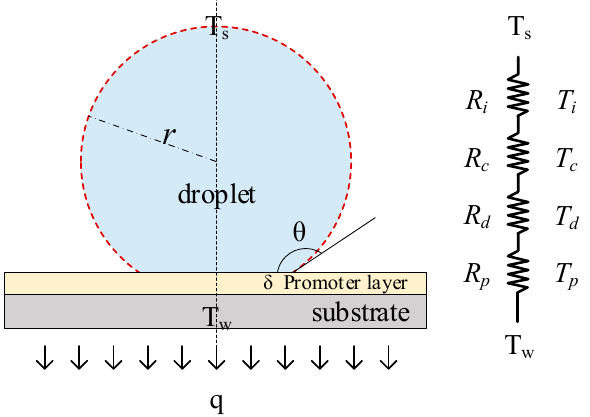
Figure 3. Schematic diagram of thermal resistance network of a single